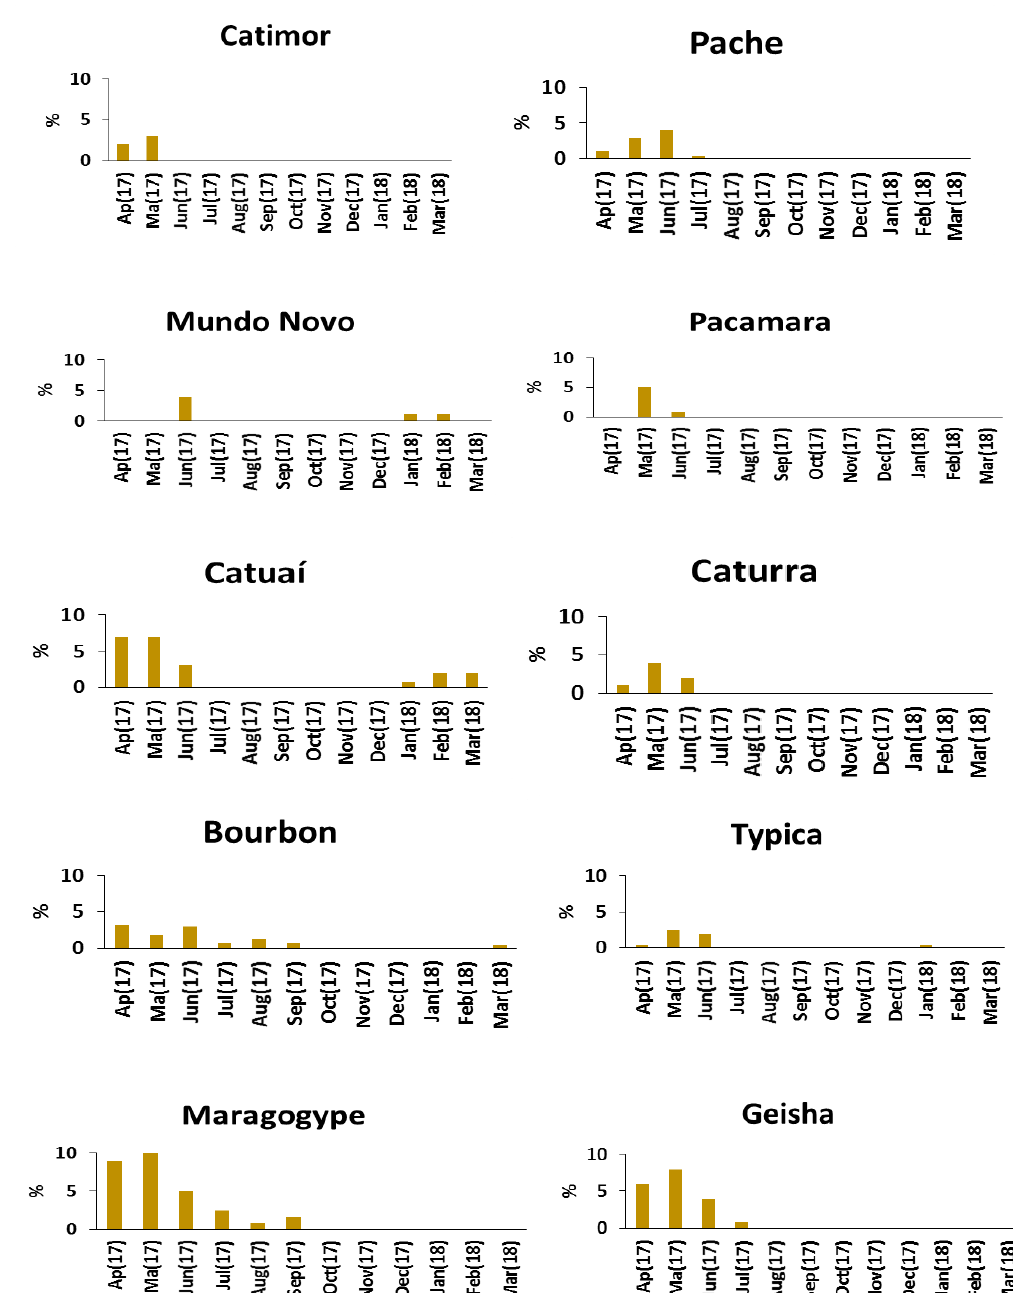
Figure 4. Coffee Leaf Rust dynamics, for each cultivar, April 2017 to March 2018, in the upper section.